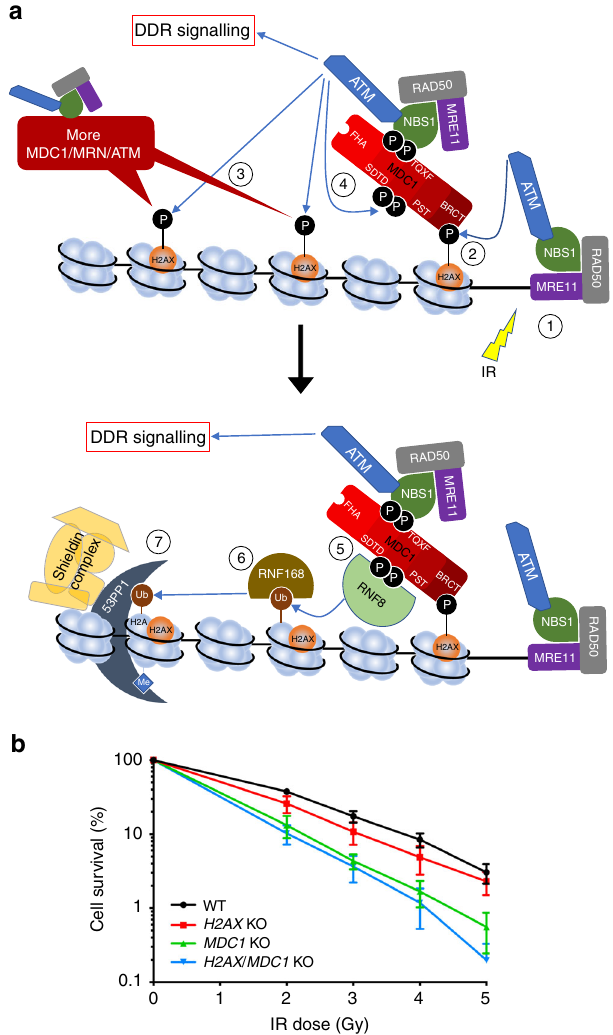
Fig. 1 MDC1 loss causes greater IR sensitivity than H2AX loss. a Diagram depicting the main events in the signal transduction pathway that leads to 53BP1 accumulation on chromatin at DNA-damage sites: (1) DSB induction and MRN/ATM recruitment/activation. (2) ATM phosphorylates H2AX and this is recognised by MDC1, which brings in more MRN and ATM. (3) MDC1- mediated accumulation of ATM results in ampli fi cation of the γ H2AX signal and, consequently, further recruitment of MDC1/MRN/ATM. (4) ATM also phosphorylates the TQXF cluster of MDC1. (5) Phosphorylated TQXF motifs are bound by RNF8, which ubiquitylates another protein(s). (6) This ubuiqitylated protein(s) serves as a docking site(s) for RNF168. (7) RNF168